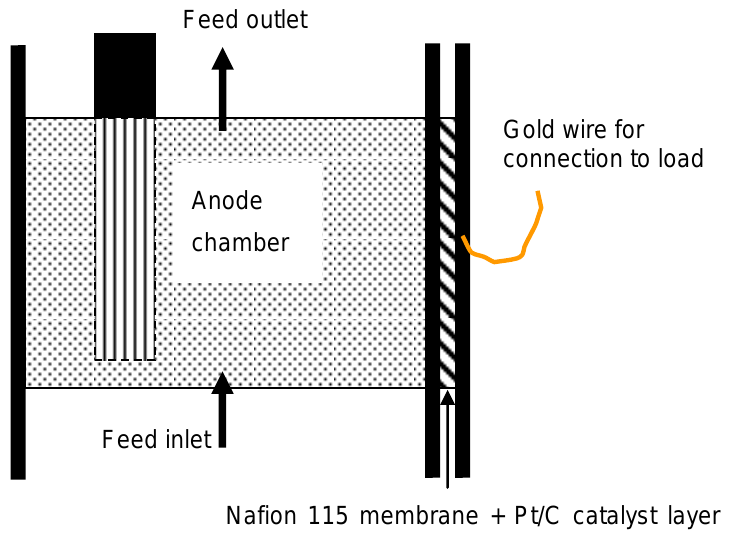
Figure 1. Schematic of the MFC. The peristaltic pump connected the anode chamber, via the feed inlet/outlet, to a 200 mL reservoir of anode